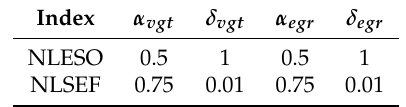
Table 3. Nonlinear function f al ( e , α , δ ) parameters.